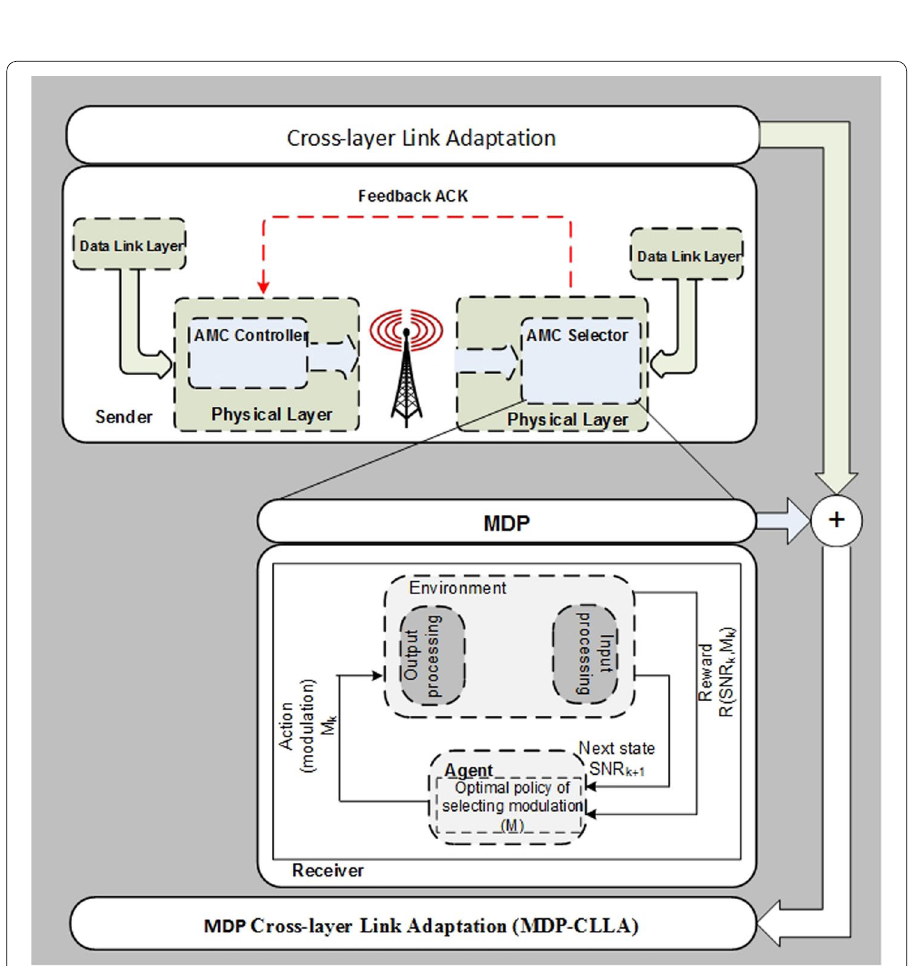
Fig. 2 Framework of the proposed MDP‑CLLA